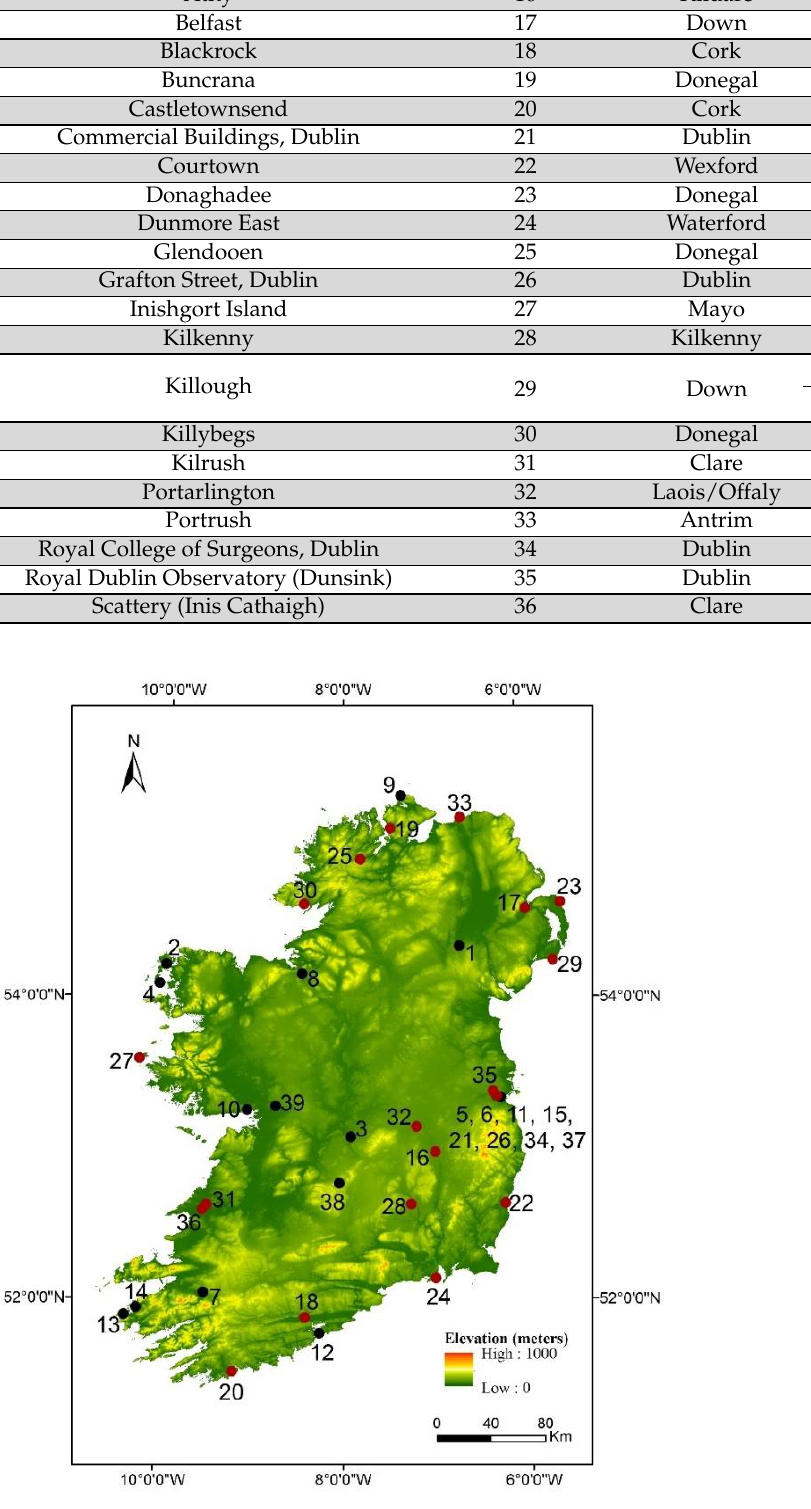
Figure 1. Location of the daily MAX and MIN long-term (black) and short-term (red) series. Numbers correspond to station numbers in Tables 1 and 2, with additional stations used in homogenisation: 37 — Merrion Square, Dublin; 38 — Gurteen; 39 — Athenry. Raster source: [23].